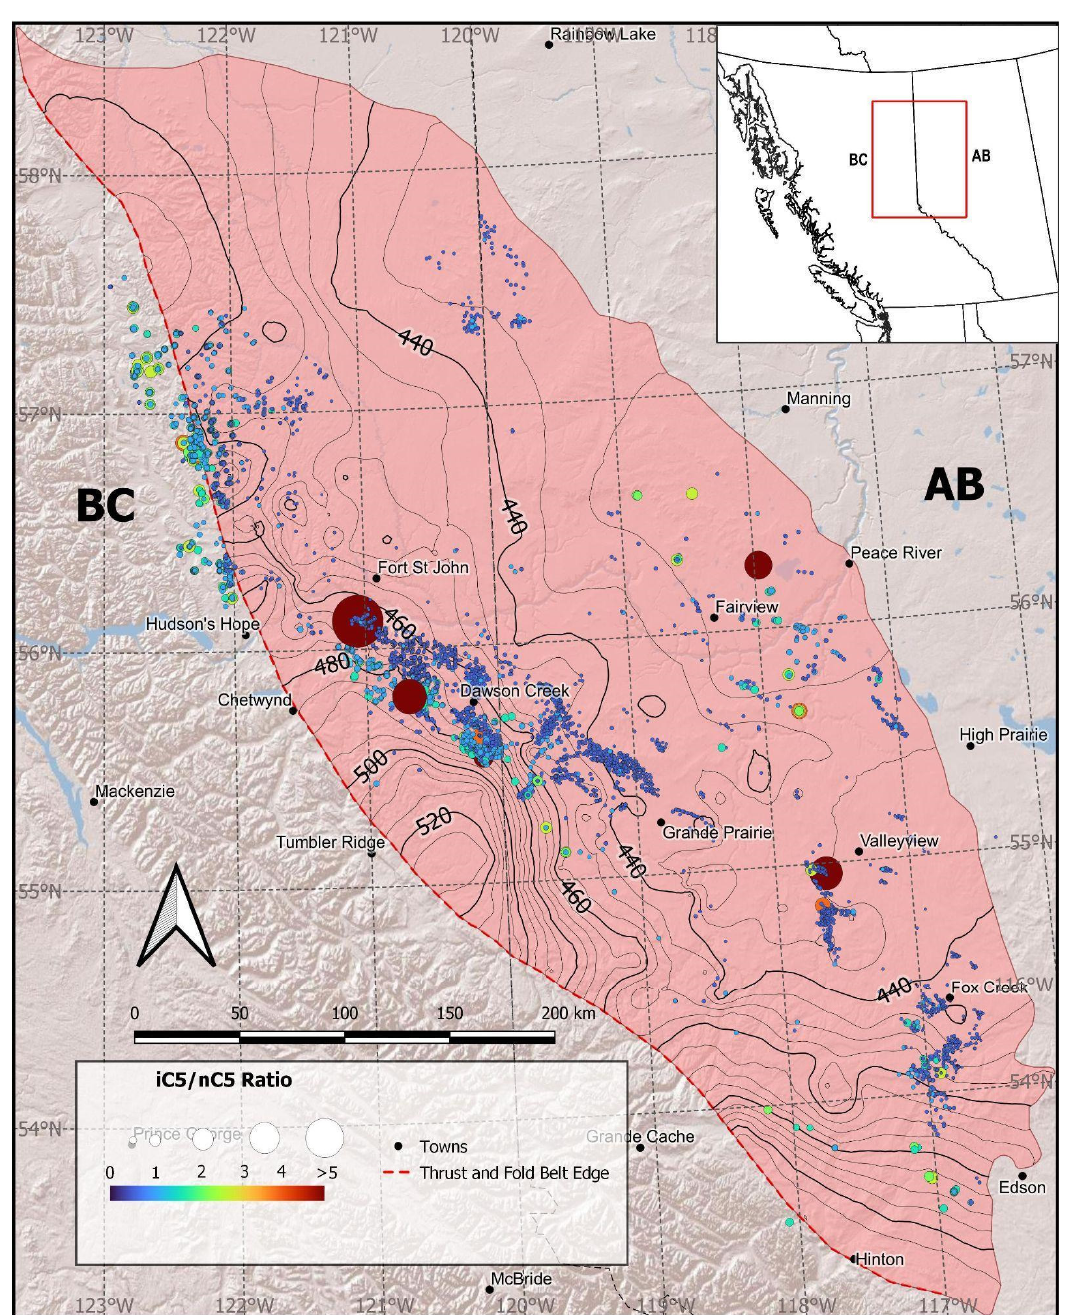
indicated by the symbols becoming larger and lighter blue and green colours. Ratios that are greater than 5 are probably anomalies and need to be further investigated.